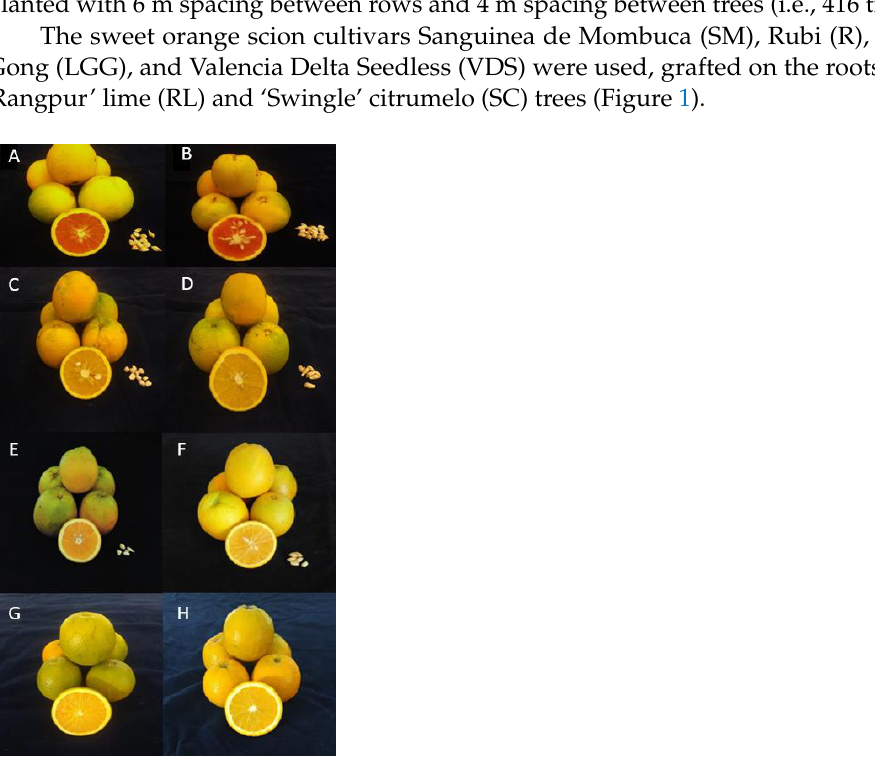
Figure 1. Fruits of sweet orange scion cultivars grafted onto two rootstocks: SM/RL ( A ); SM/SC ( B ); R/RL ( C ); R/SC ( D ), LGG/RL ( E ); LGG/SC ( F ); VDS/RL ( G ); VDS/SC ( H ).